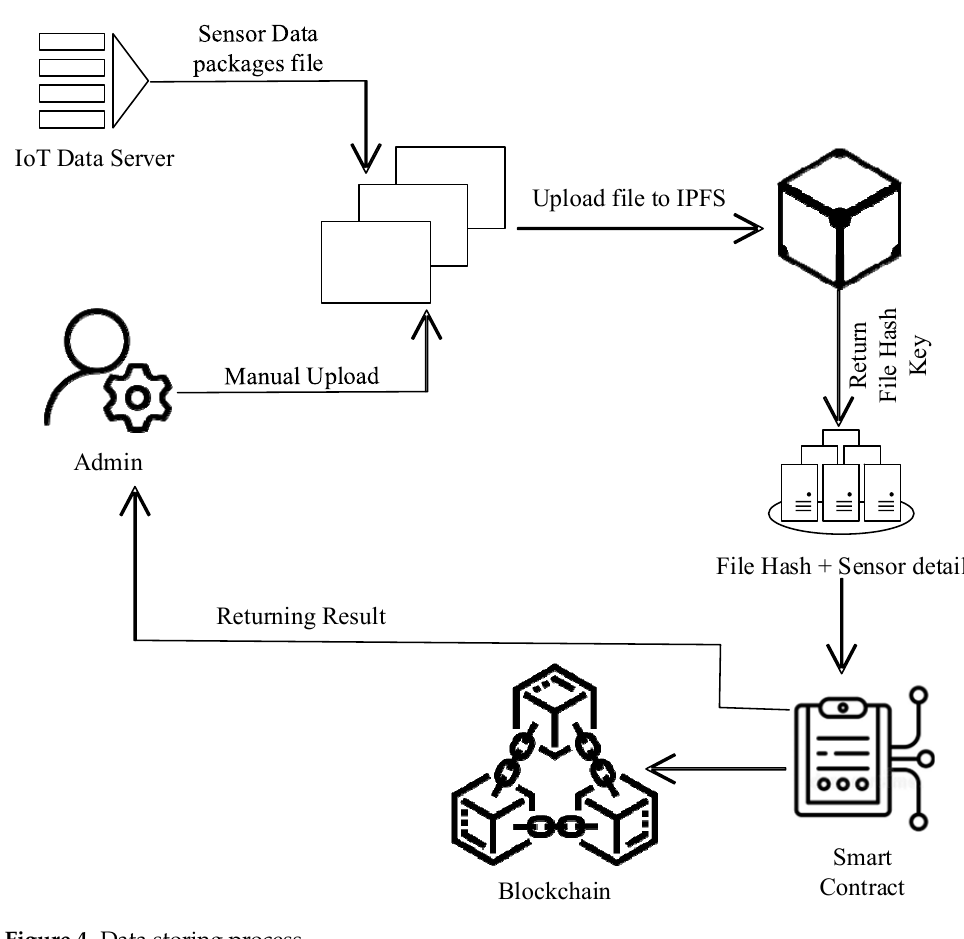
Figure 4. Data storing process.